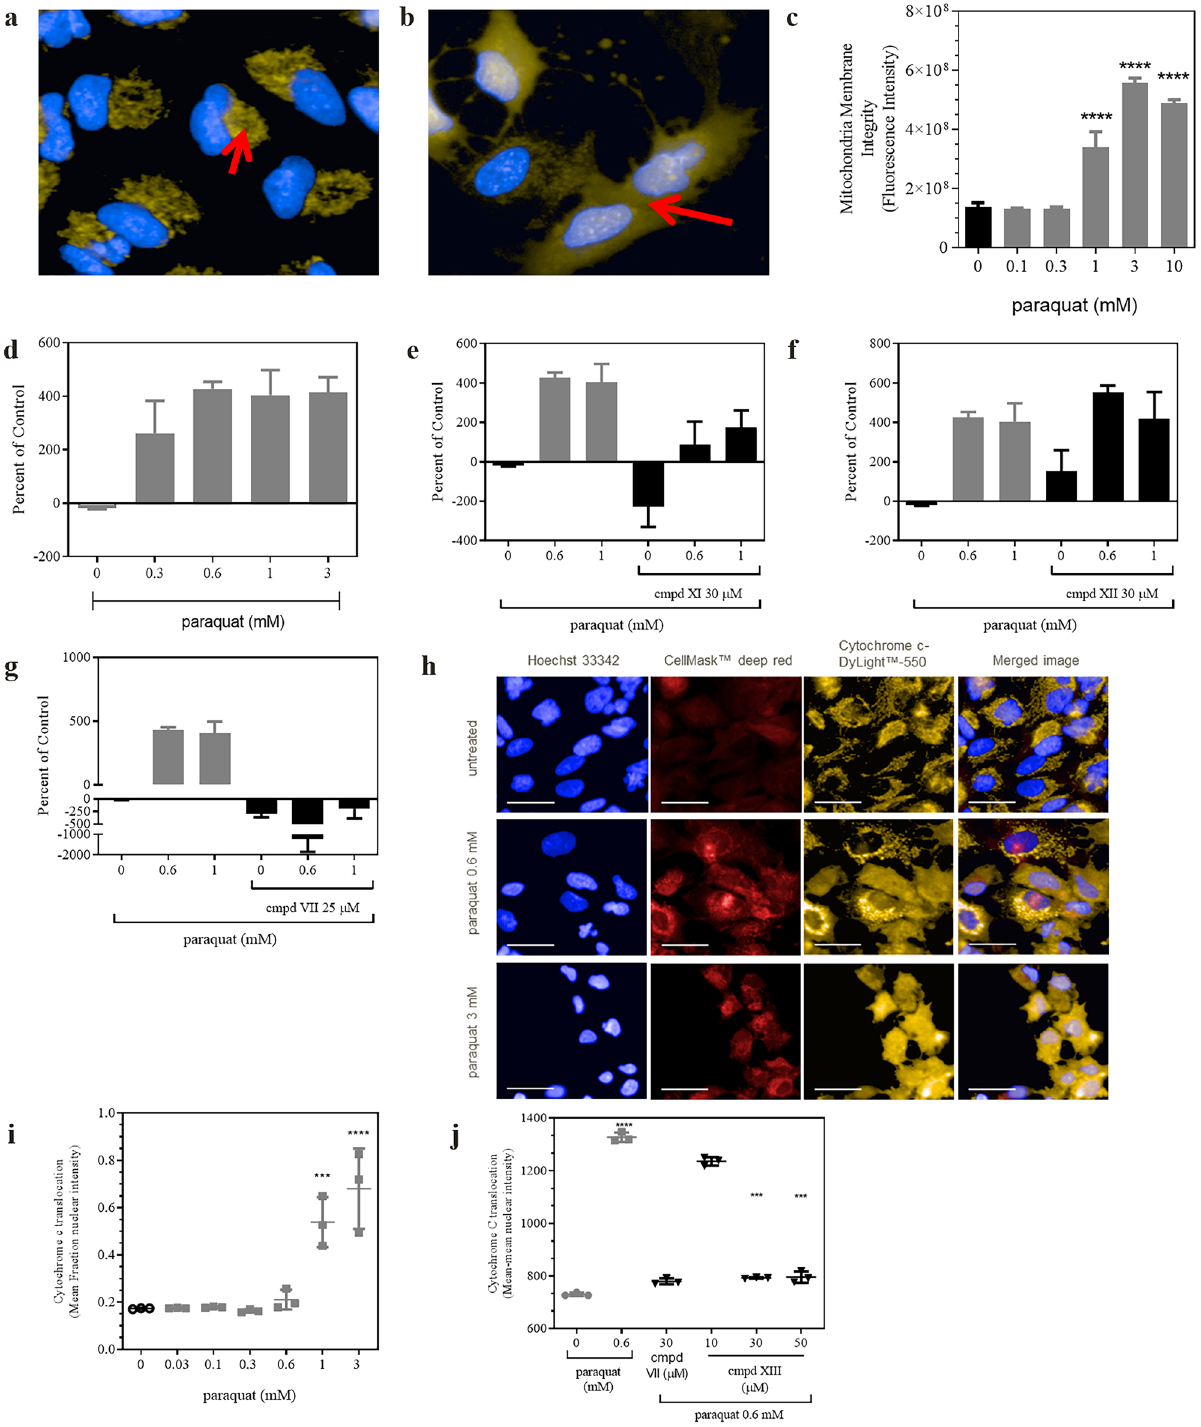
Figure 6. Effects of paraquat on mitochondrial membrane integrity, mtDNA damage and cytochrome c translocation. In ( a ) baseline values of mitochondrial integrity are noted by the punctate orange colors whereas in ( b ), paraquat exposure for 24 h elicits a diffuse characteristic in A549 cells. MitoTracker™ orange dye (overlaid orange) was used to demarcate mitochondria (red arrows) and Hoechst 33342 (blue) to denote the nucleus. ( c ) provides graphical representation of the mean values obtained from the imaging data from 3 independent experiments. Asterisks represent p < 0.0001 by 1-way ANOVA with Dunnet’s post hoc analyses. In ( d ), paraquat concentration-dependently damaged mtDNA as measured using two mitochondrial primers described in Methods. Values are depicted as percent of baseline control measurements. For ( e – g ), representative examples obtained from 3 independent experiments show the impact of compounds XI , XII and VII , respectively, on preventing mtDNA damage. For ( h – j ), changes in cytochrome c translocation are depicted in representative images using anti-cytochrome c -DyLight™-550 (yellow), CellMask™ Deep Red (red) and Hoechst 33342. In this case, OGG1 activators were applied 2 h prior to paraquat rather than 4 h in the other experiments. For ( i ) statistical analyses (ANOVA with Dunnett’s post-test), asterisks represent p < 0.0001 and for ( j ) PQ value was p < 0.0001 vs control while 30 and 50 µM of the test compound resulted in p = 0.0002 and 0.0003,